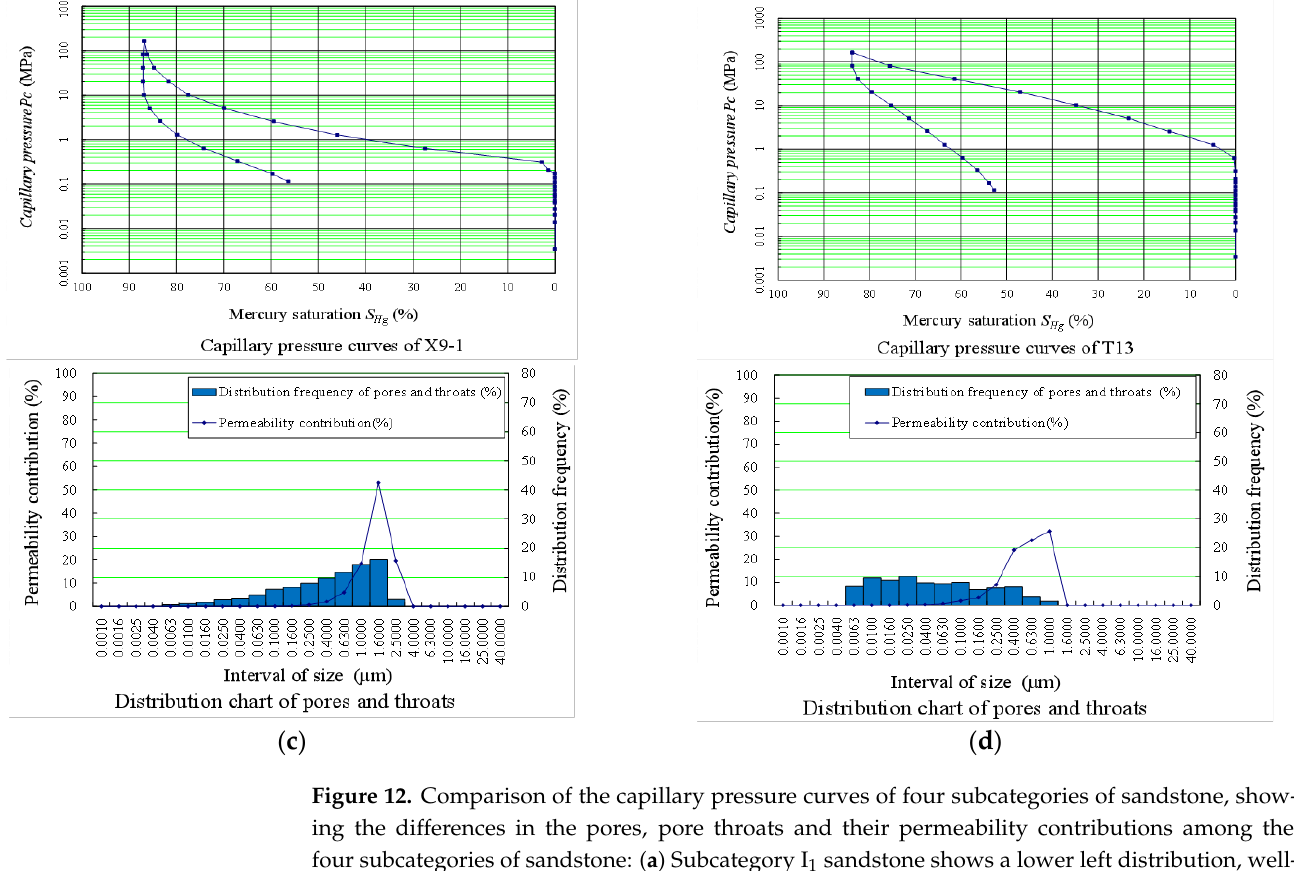
Table 10. Parameters and recommendations for different sandstone subcategories.